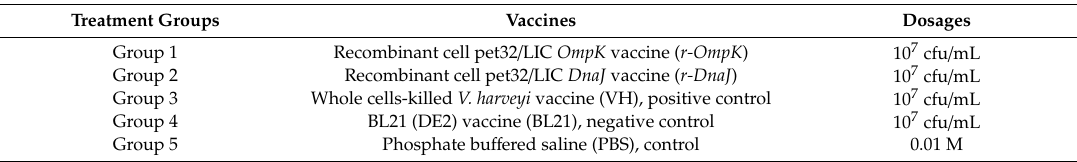
Table 1. Experimental group for fish vaccination